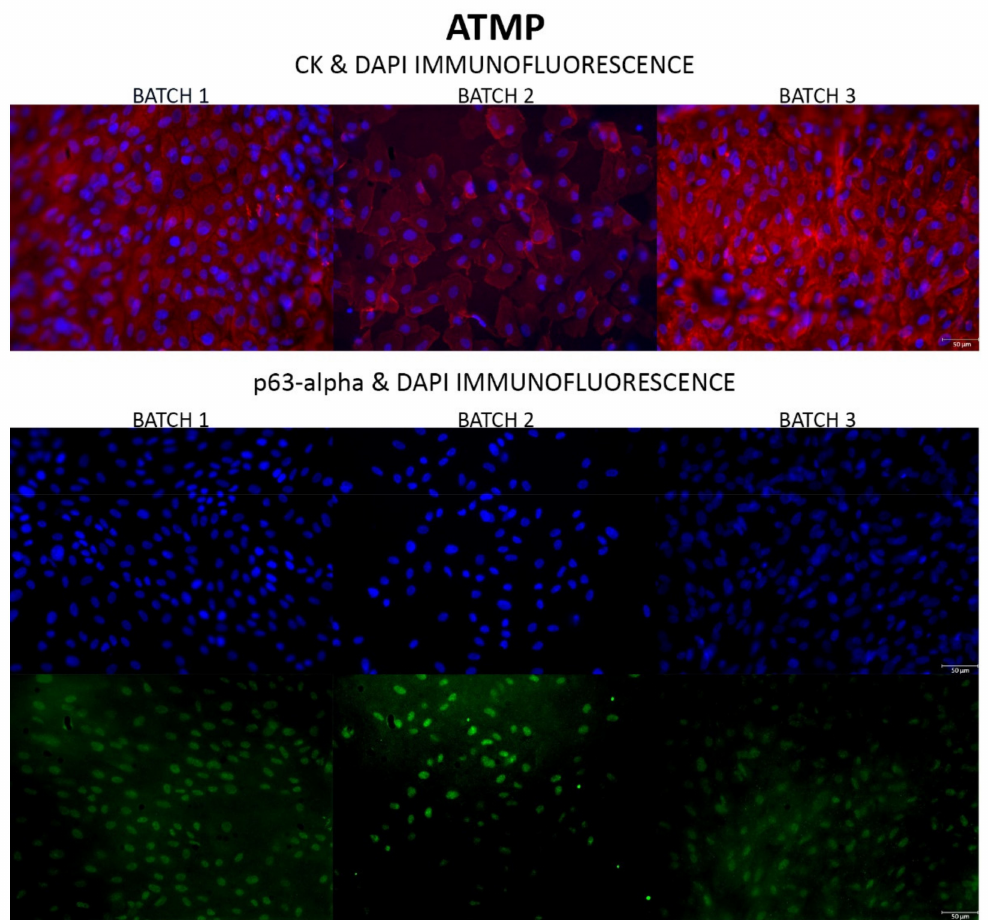
Figure 5. Immunofluorescence analysis of ATMP in which CK positive LSC appear red, p63-alpha positive LSC appear green and DAPI appears blue (Scale: 50 µ m). ATMP: Advanced Therapy Medicinal Products; CK: cytokeratin; LSC: Limbal Stem